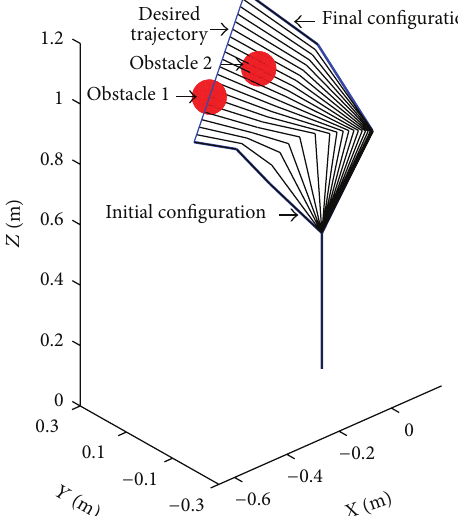
Figure 5: Trajectory of robot before obstacle avoidance trajectory planning.